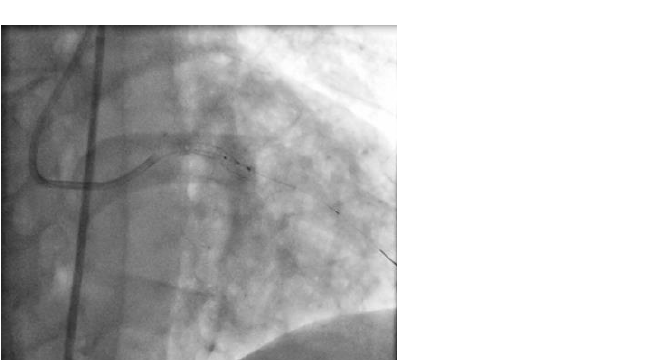
Figure 4. wiring of the left anterior descending artery